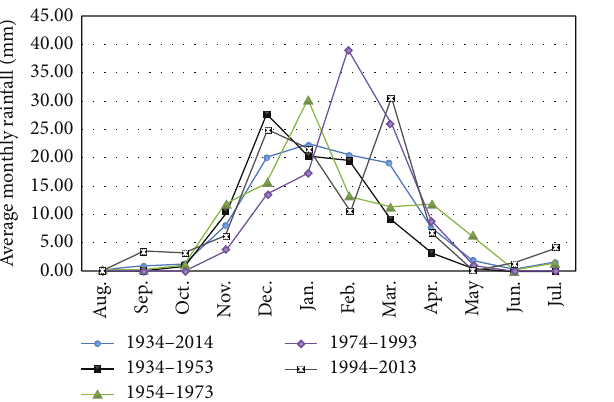
Figure 7: Variability in monthly peak rainfall over different time lines in Sharjah City.